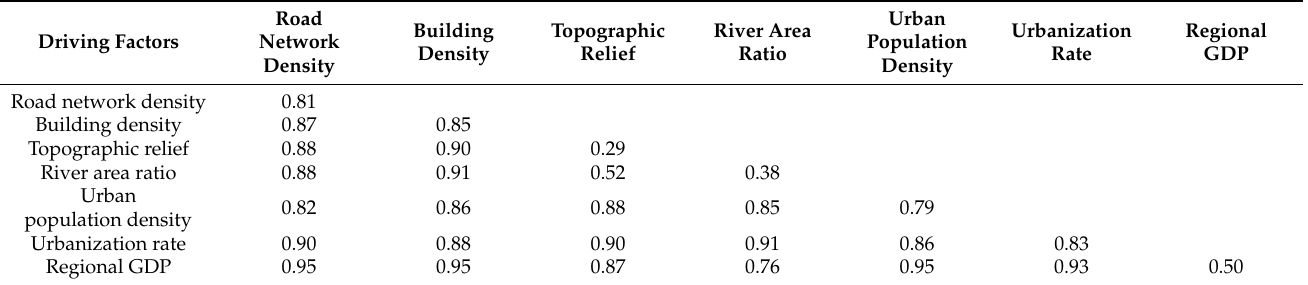
Table 6. Interactive detection